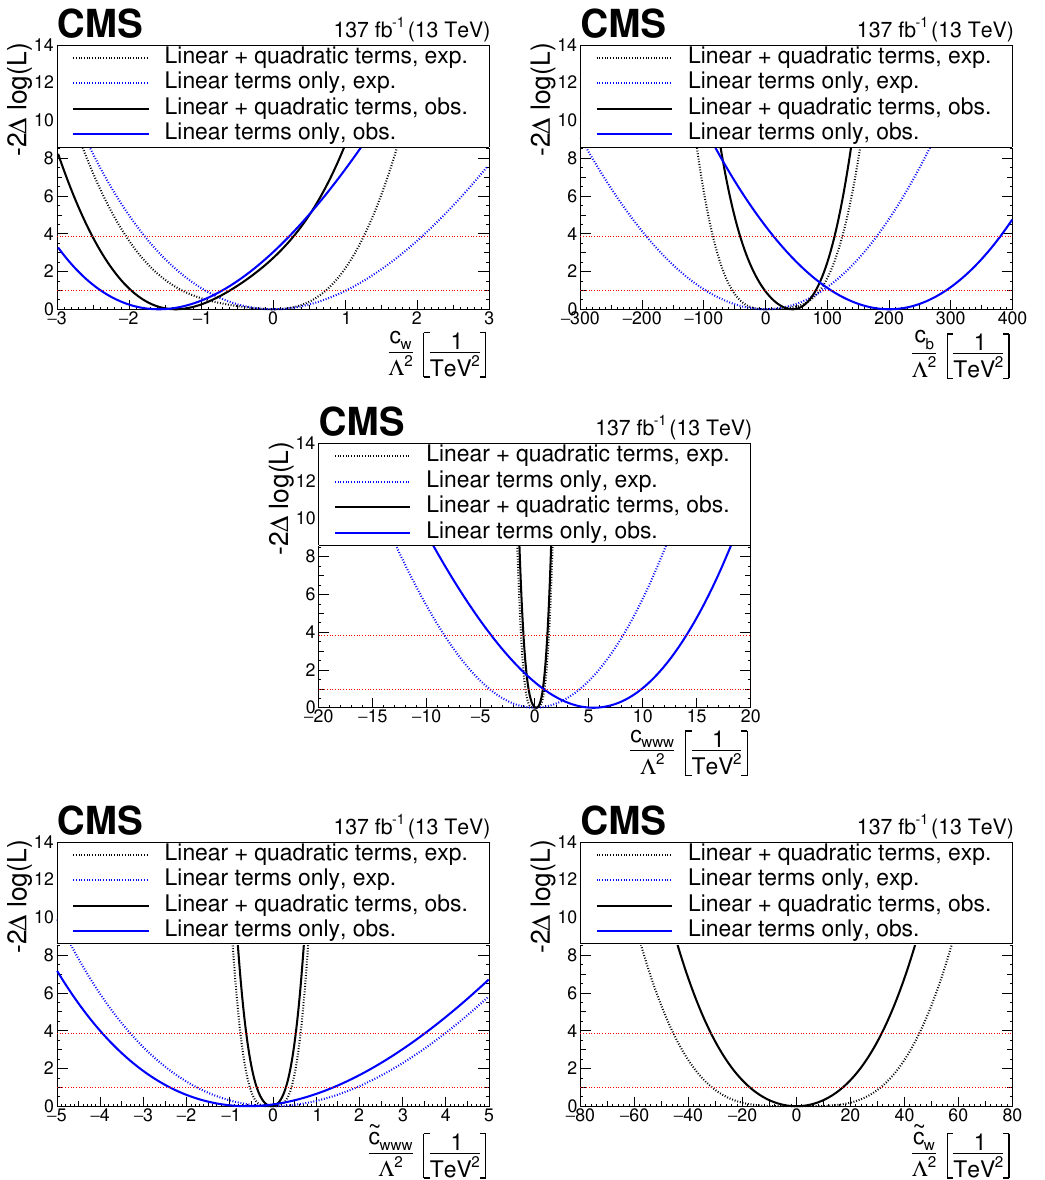
Figure 20 . Observed and expected evolution of the log likelihood of the best fit point as a function of each of the considered EFT parameters for both the linear (only interference between SM and BSM physics) and quadratic (both interference and purely BSM term) approaches to the EFT signal modelling. Very low sensitivity to the interference-only term, corresponding curve is not